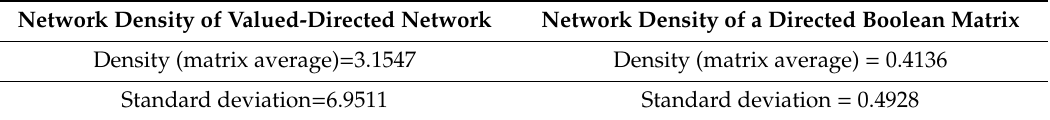
Table 2. Network